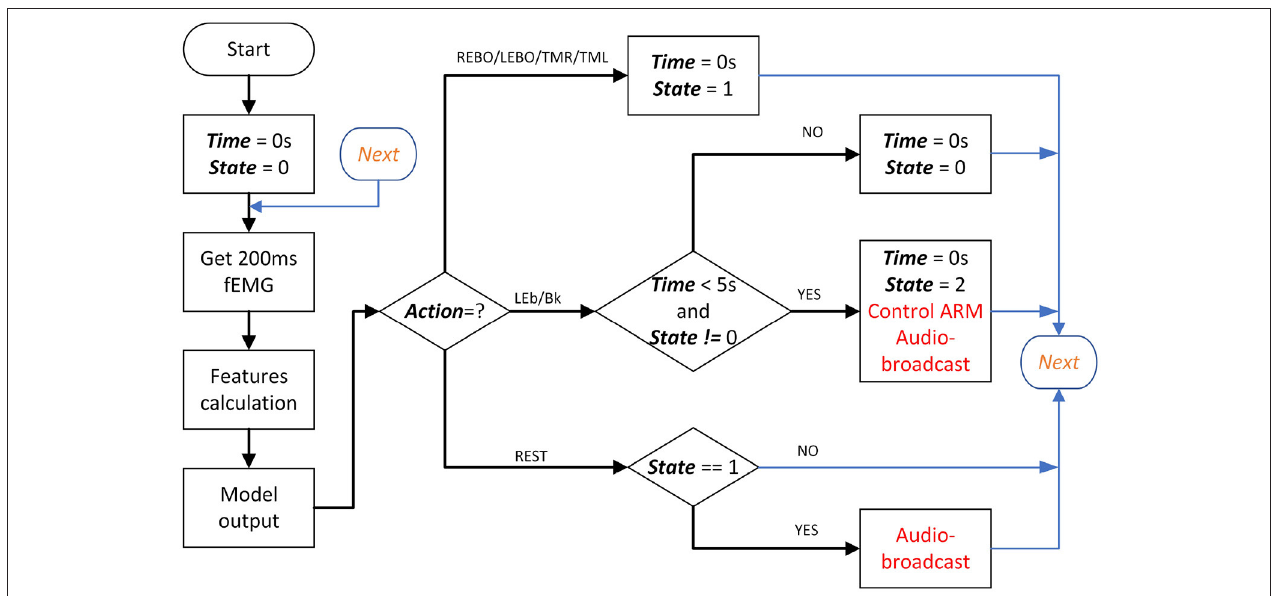
FIGURE 7 | Online control flow chart base on FCI. In the figure, the black, bold, and italicized words are the main variables, and the red part is the robotic arm control and voice